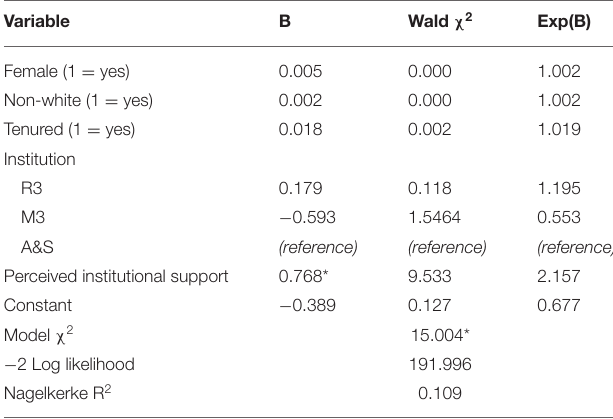
TABLE 3 | Fixed effects regression coefficients predicting likelihood of mentoring undergraduates across three